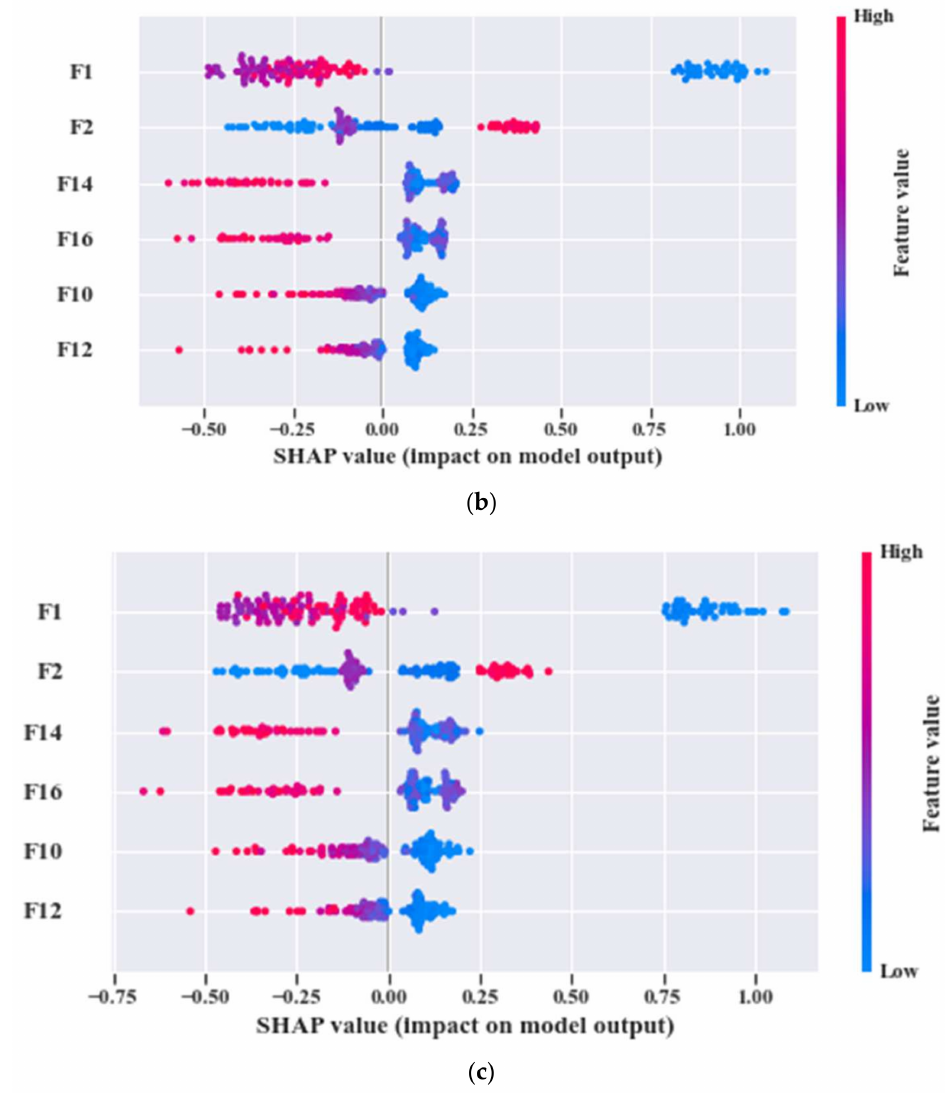
Figure 15. Summary plots for all the test datasets with associated SHAP values: ( a ) SHAP values for model 1, ( b ) SHAP values for model 2, and ( c ) SHAP values for model 3. Table 6. Diagnostic performance of the invariant